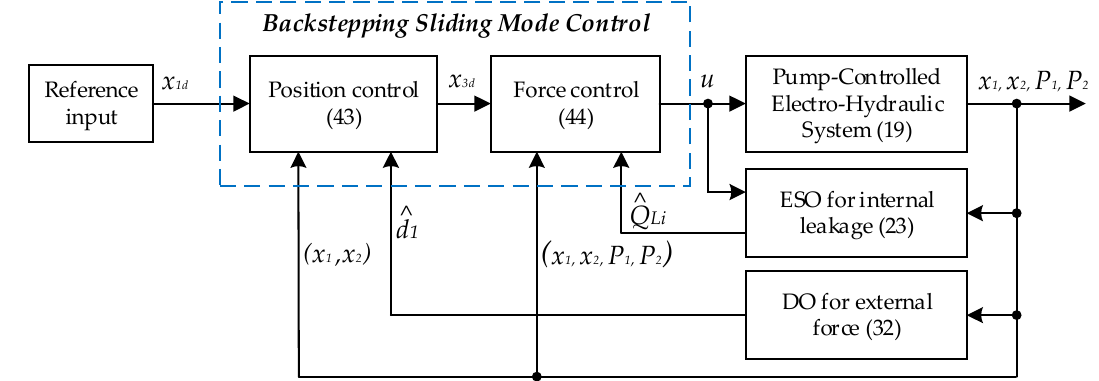
Figure 2. Diagram of the fault estimation and tolerant control scheme.